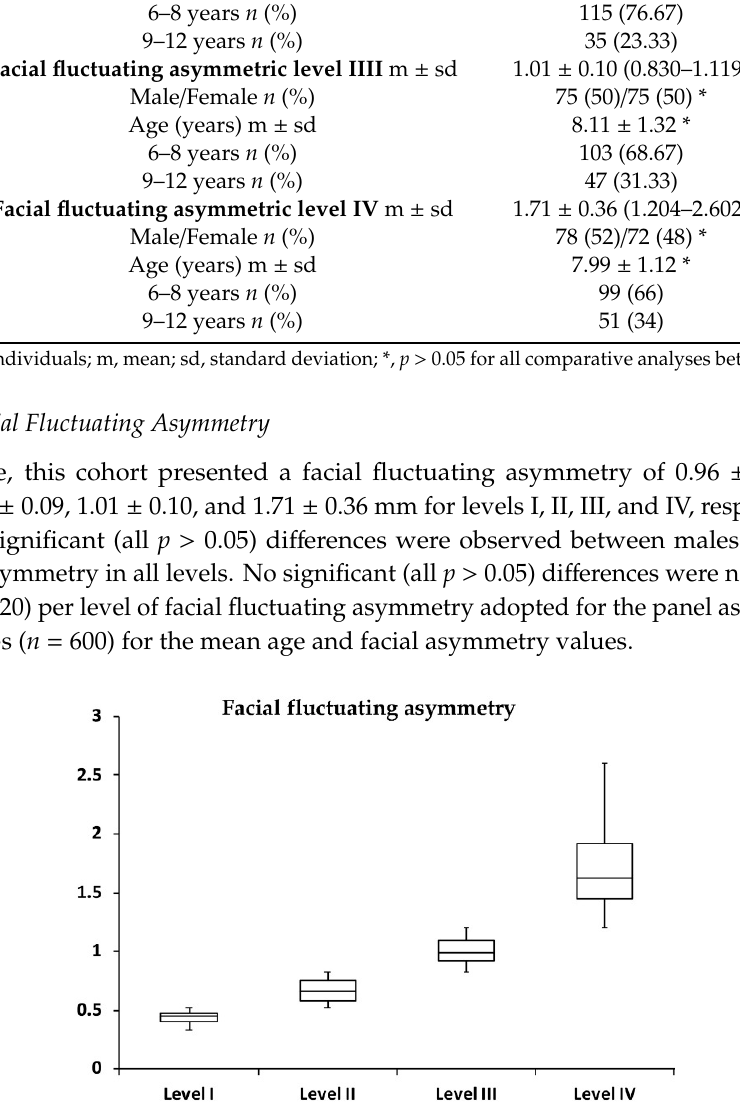
Figure 3. Box plot demonstrating the distribution of facial fluctuating asymmetry ( n = 150 for level of asymmetry).